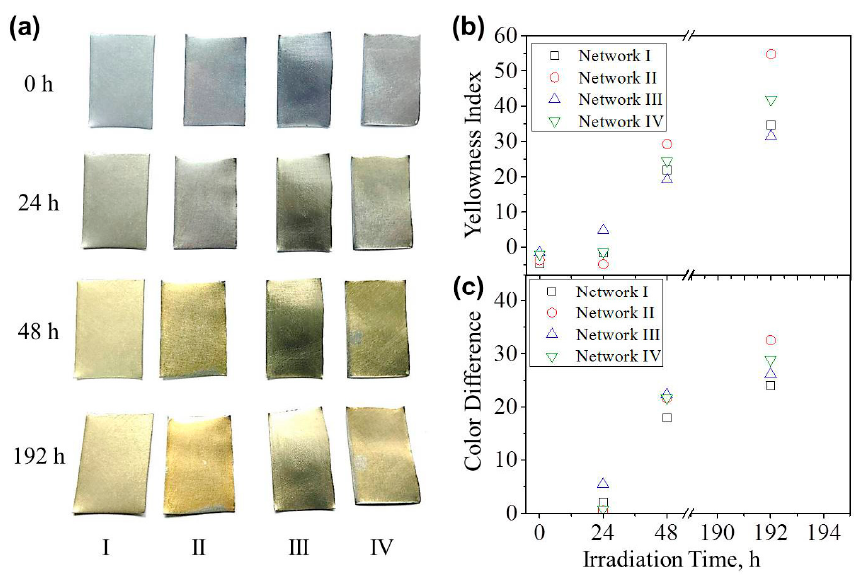
Figure 7. ( a ) Photos of the coatings with Networks I–IV after UV illumination; ( b , c ) Correspondingly calculated ( b ) yellowness index and ( c ) color difference.